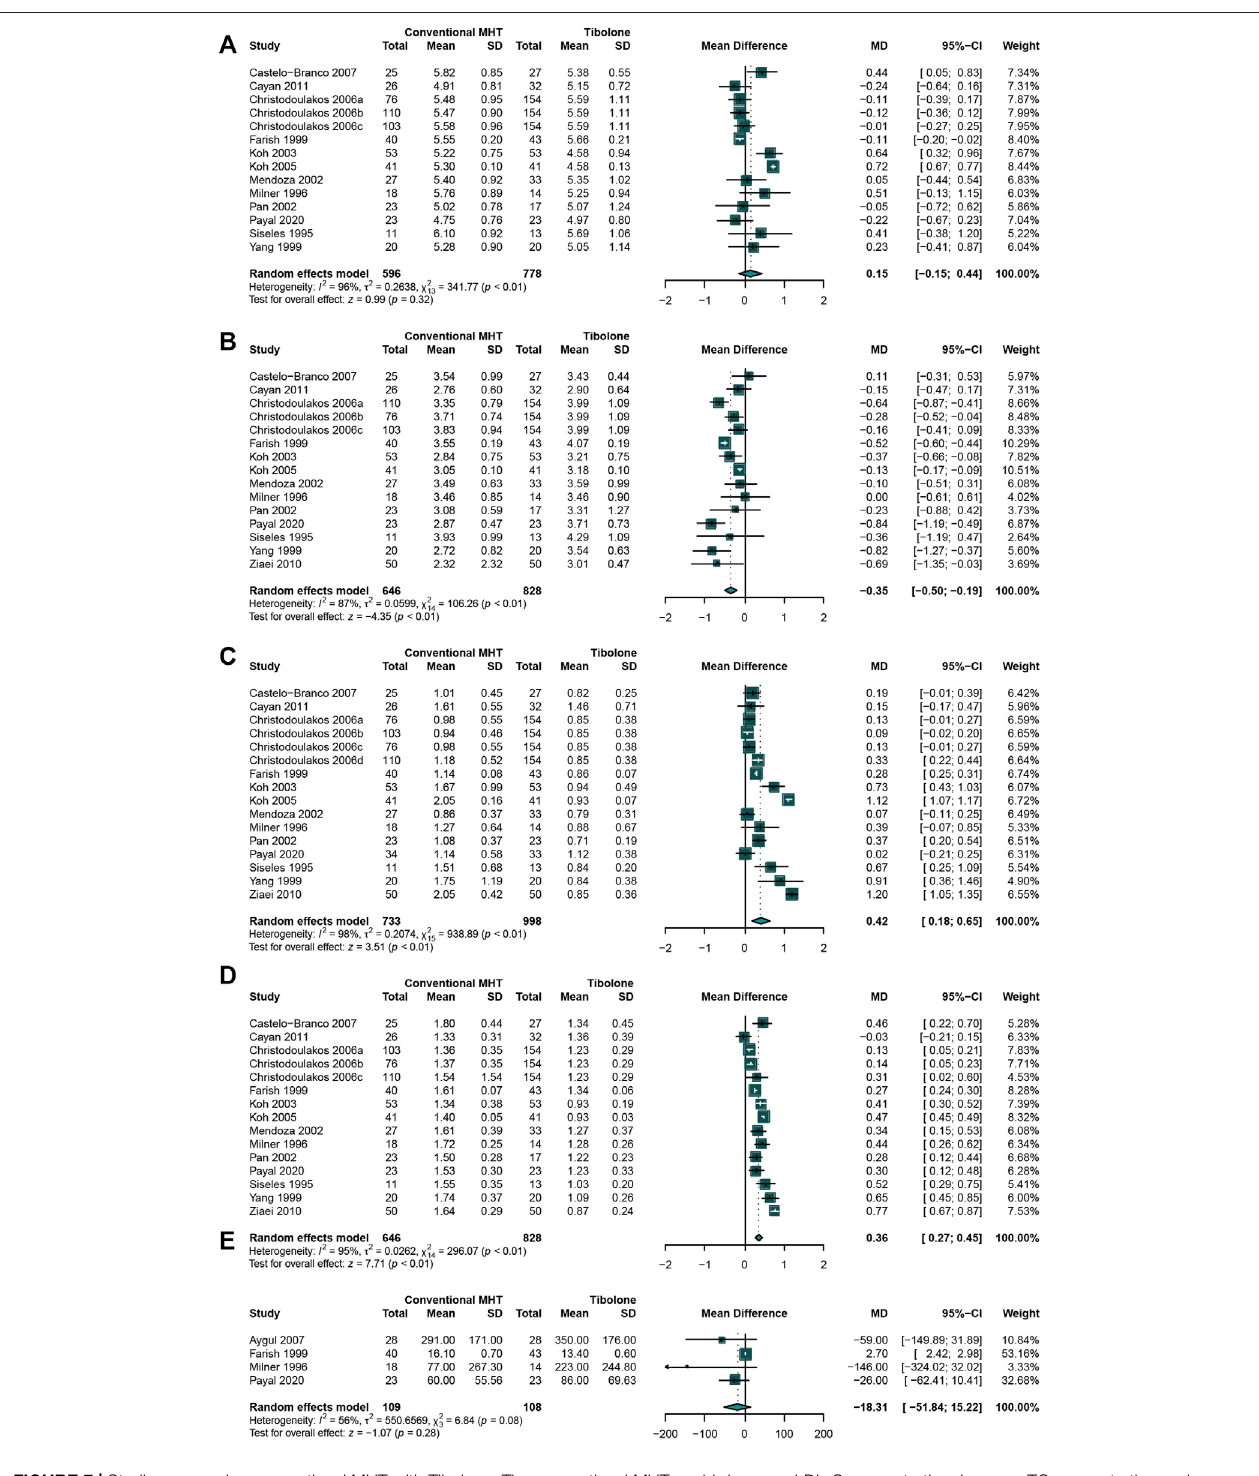
FIGURE 7 | Studies comparing conventional MHT with Tibolone. The conventional MHT could decrease LDL-C concentration, increase TG concentration and HDL-CconcentrationcomparedwithTibolone. (A) TCconcentration; (B) LDL-Cconcentration; (C) TGconcentration; (D) HDL-Cconcentration; (E) Lp(a)concentration.